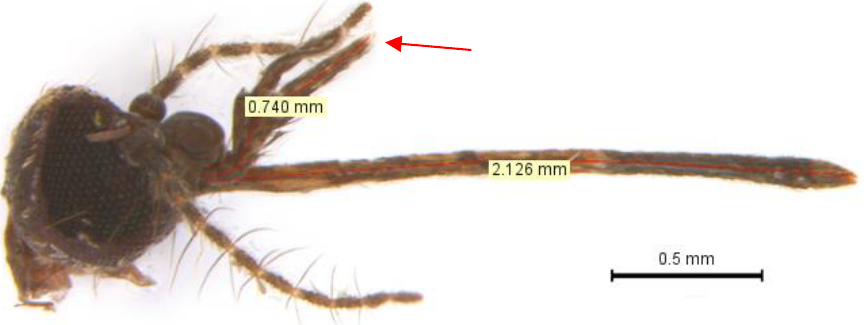
Figure 2. Head of Mansonia pseudotitillans (ID ZooB592) showing (arrow) maxillary palpus (0.740 mm) about 0.29 of the proboscis total length (2.126 mm).